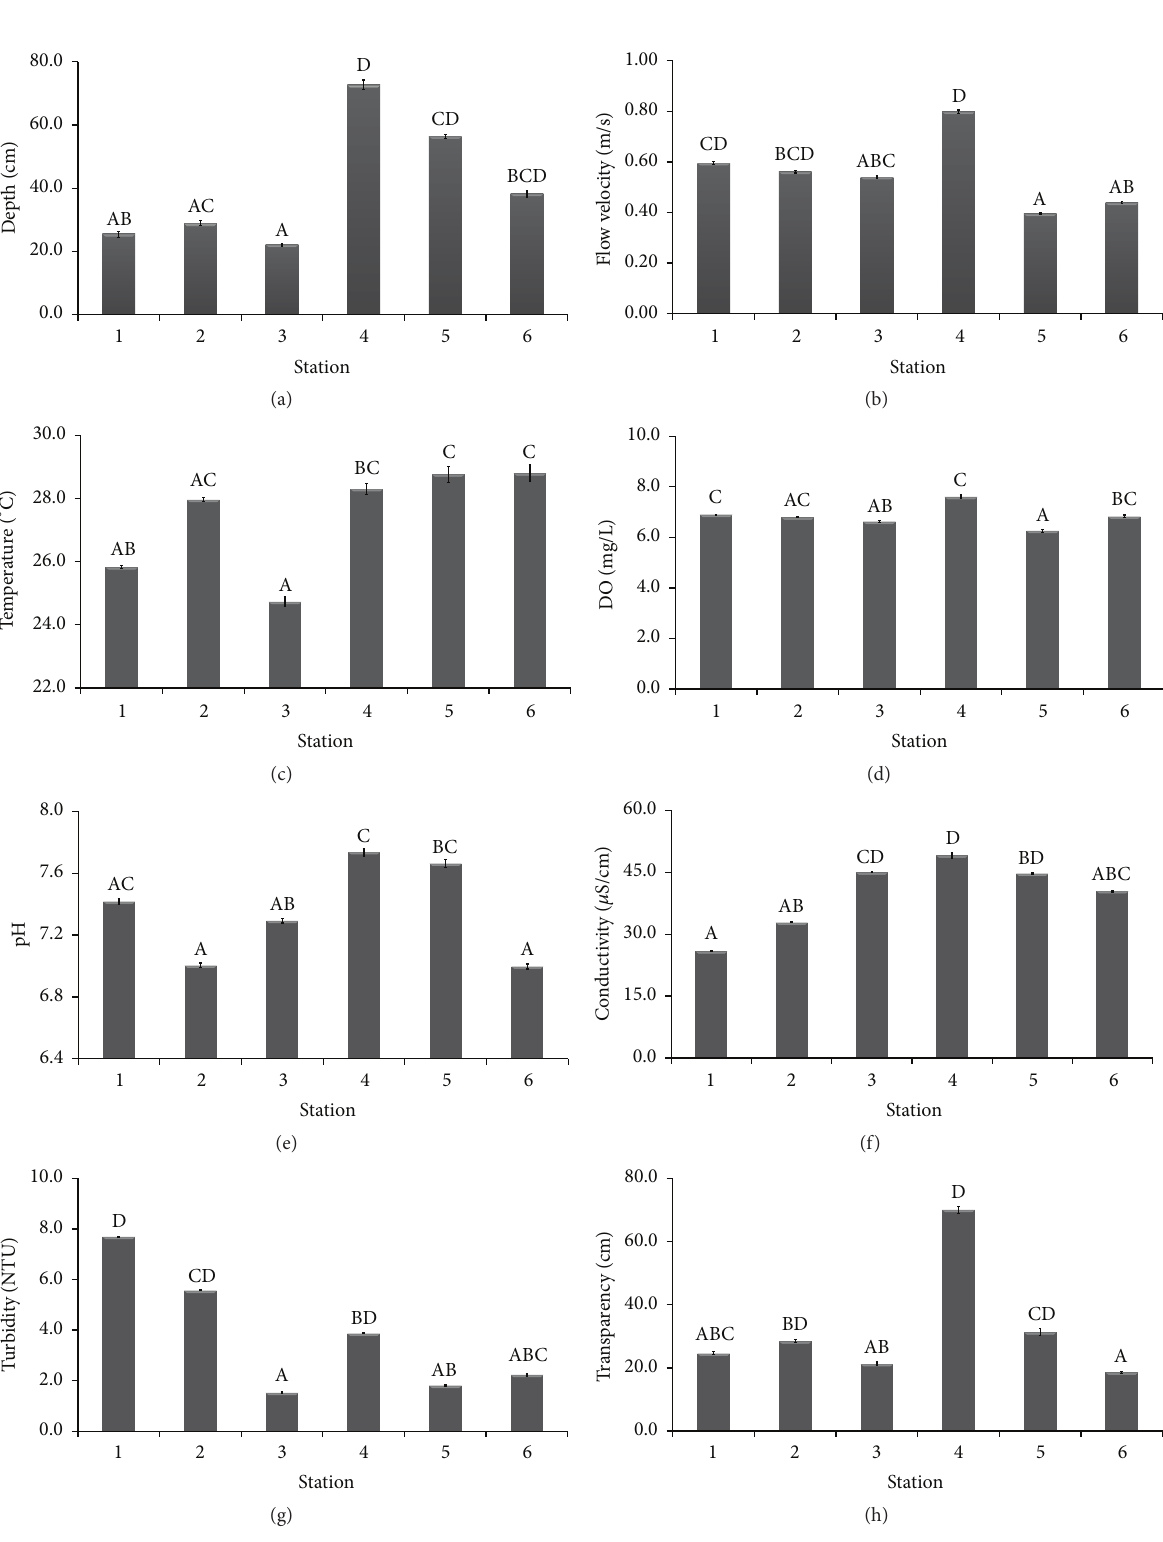
Figure 2: In situ water quality parameters of (a) depth, (b) flow velocity, (c) temperature, (d) DO, (e) pH, (f) conductivity, (g) turbidity, and (h) transparency collected at the six sampling stations located at the upper reaches of two main tributaries of Batang Baleh (different letters indicate significant difference at 𝑝 value ≤